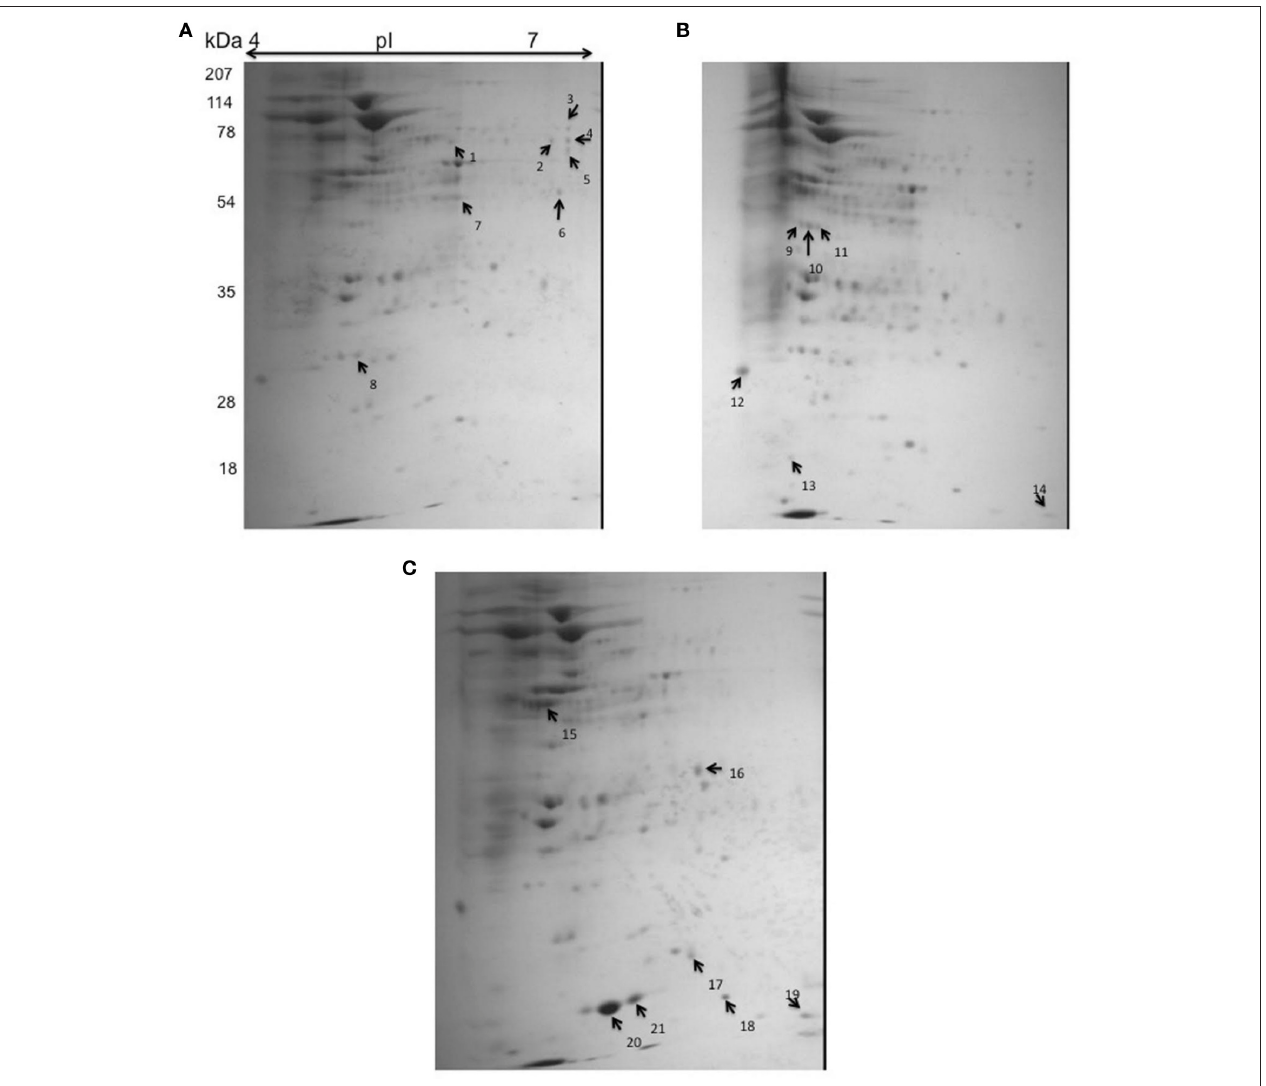
FIGURE 7 | 2D gel electrophoresis for S-Rv2159c and As-Rv2159c strains. The cytoplasmic cell extracts of S-Rv2159c, As-Rv2159c and Rv constructs in M. tuberculosis were subjected to 2D gel electrophoresis. The CBB R250 stained gels (A) Rv, (B) S-Rv2159c, and (C) As-Rv2159c were shown. The arrow marks represents the difference in spots using PDQuest software were analyzed by mass